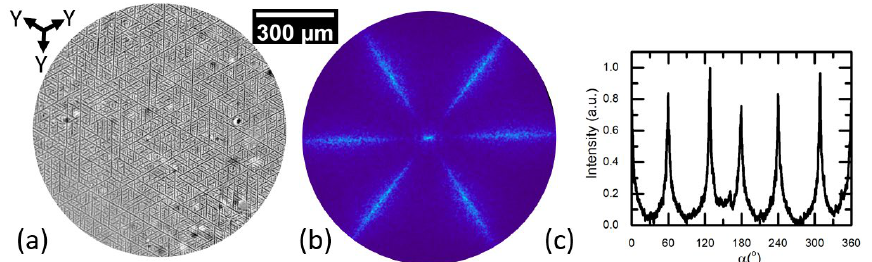
Figure 5. ( a ) Instantaneous optical image of the domain structure after background subtraction. ( b ) The Fourier transform of the image. ( c ) The angular convolution of the Fourier transform. Applied field 8 kV/mm.